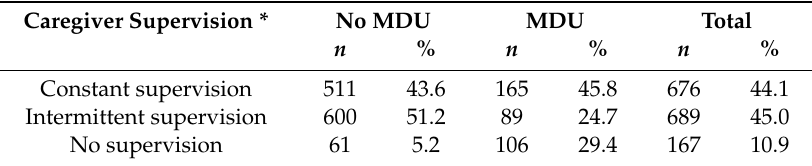
Table 1. Caregiver supervision by minutes of no mobile device use (No MDU) compared with minutes of mobile device use (MDU).